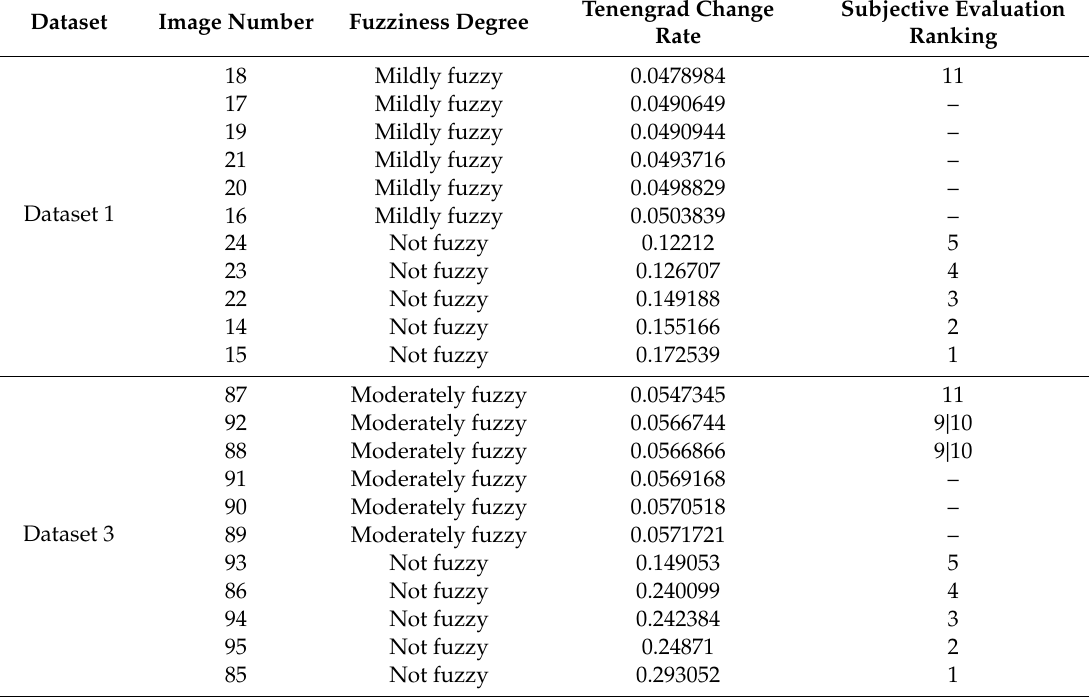
Table 2. The image definition results with Tenengrad gradient changes.